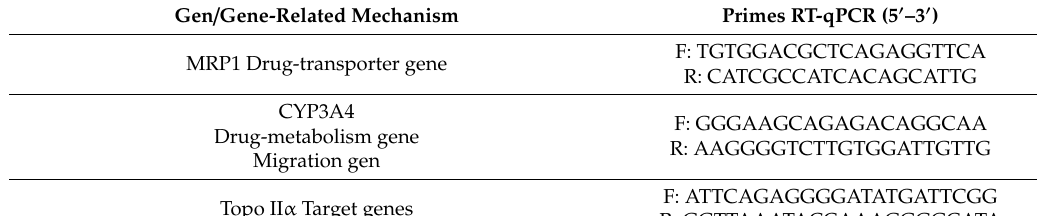
Table 2. Sequences of the primers used in reverse transcription-quantitative PCR